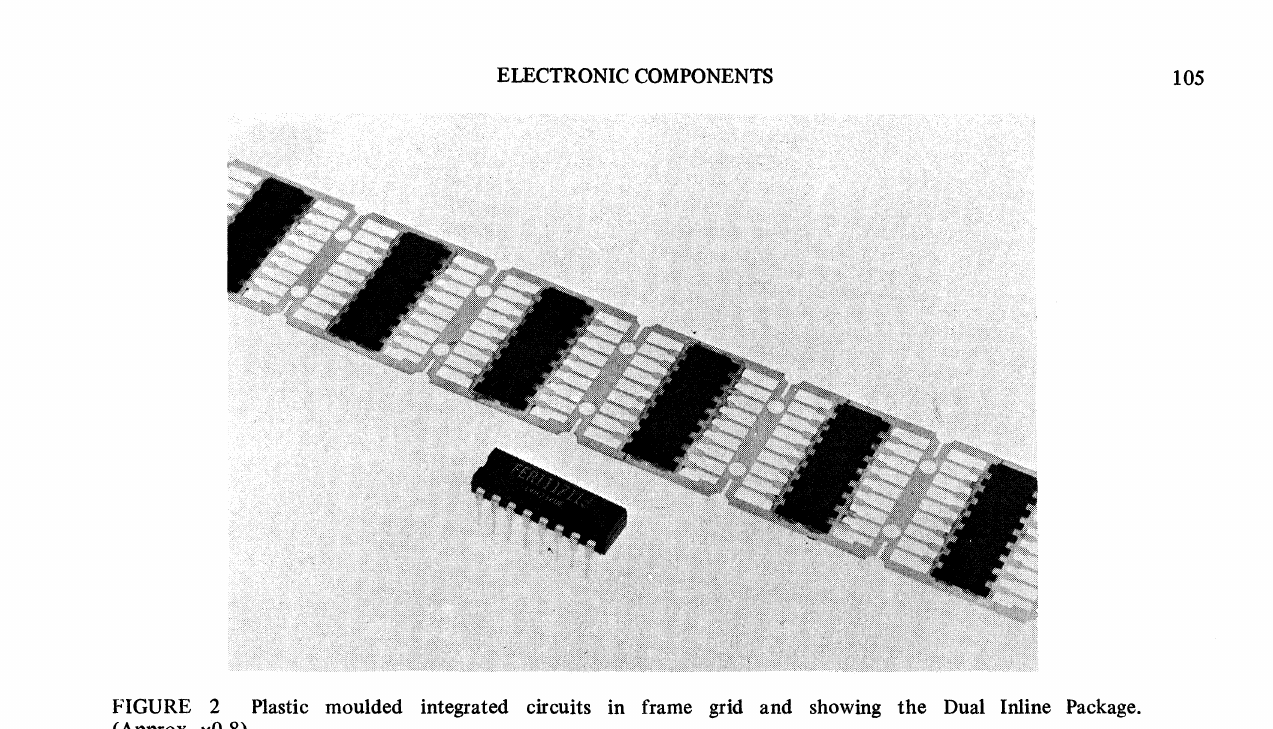
FIGURE 2 Plastic moulded integrated circuits in frame grid and showing the Dual Inline Package. (Approx.